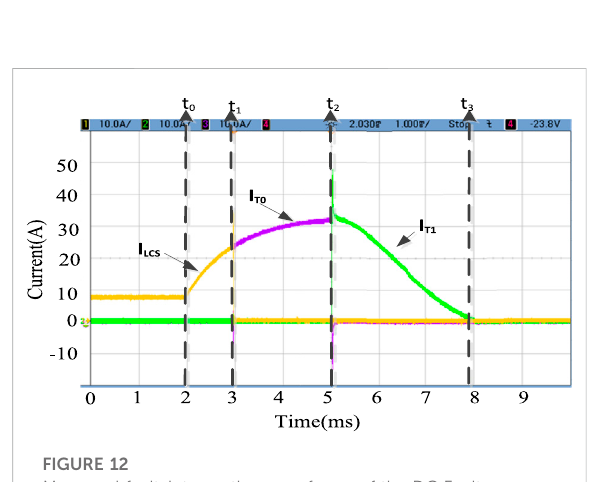
FIGURE 12 Measured fault-interrupting waveforms of the DC Fault